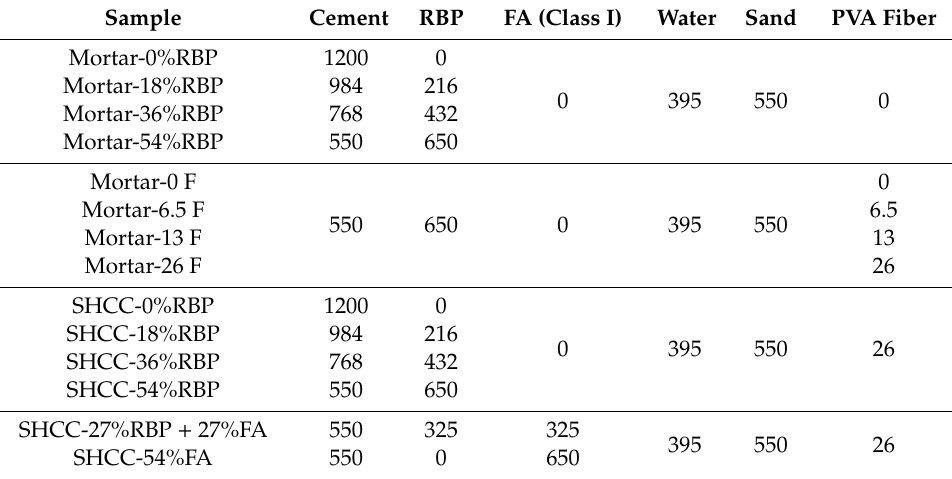
Table 1. Mix proportion of the mortar and SHCC with RBP